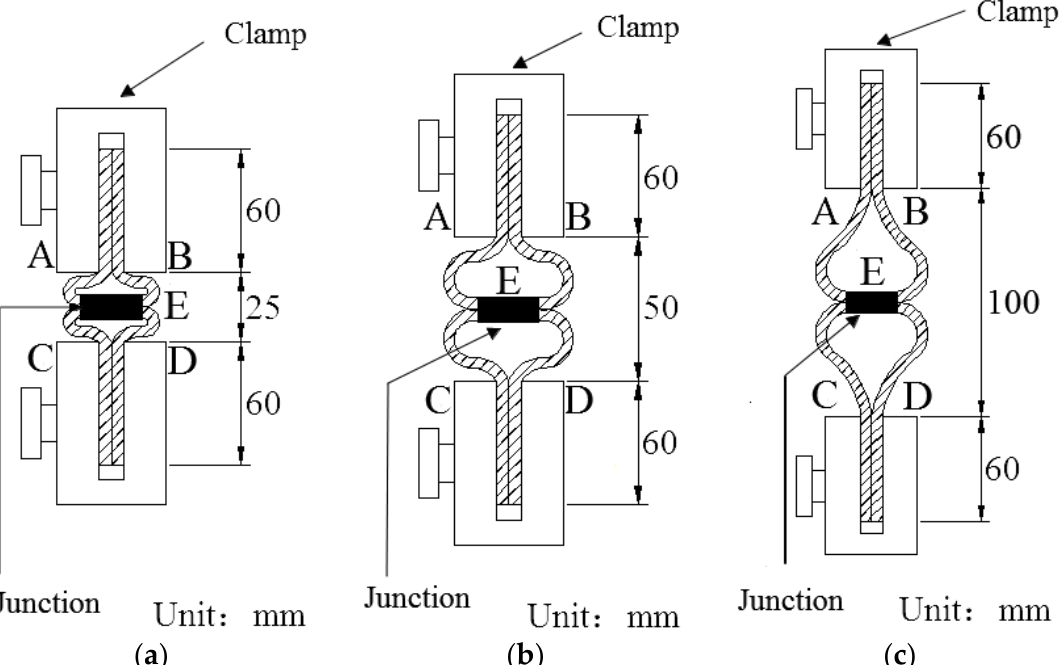
Figure 7. Peeling tests under different clamping distances: ( a ) 25 mm, ( b ) 50 mm, ( c ) 100 mm.